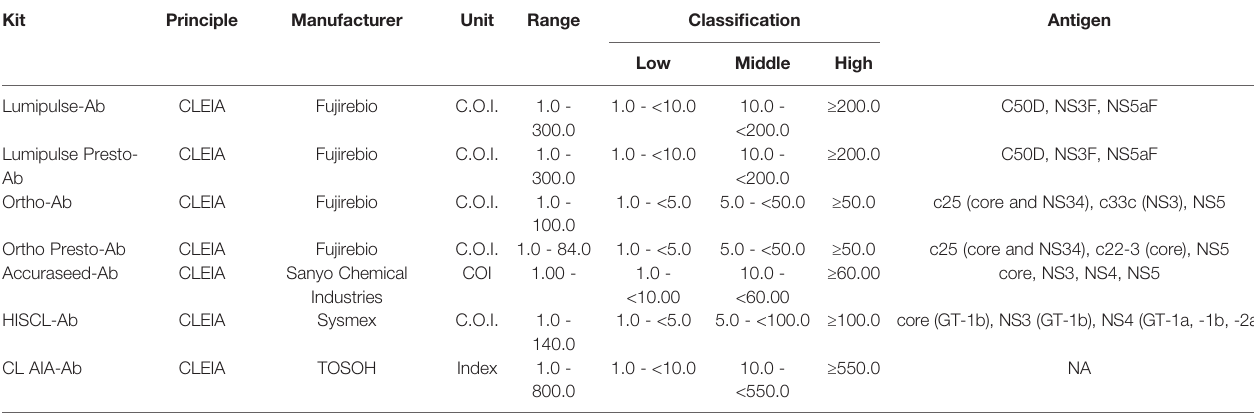
TABLE 1 | Anti-HCV detection kits providing antibody titer classi fi cation.